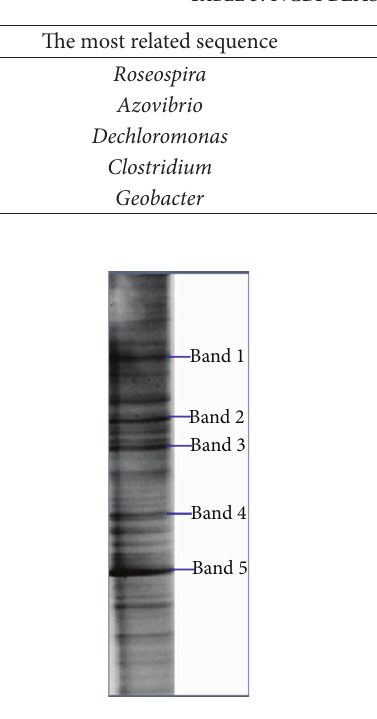
Figure 4: DGGE fingerprint of 16S rDNA fragments of activated sludge collected from anoxic tank in the two-sludge process pro- posed